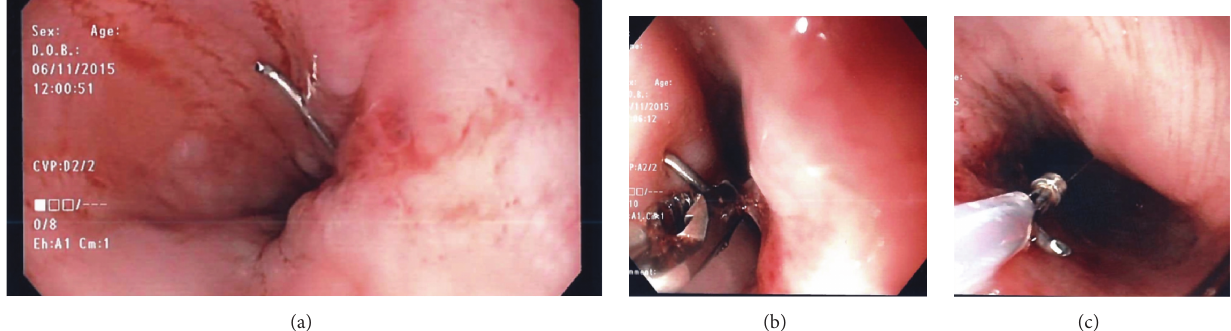
Figure 2: The fractured EUS needle visible in the esophageal lumen with a gastroscope (a). Multiple removal attempts with an alligator forceps (b) and an extraction basket